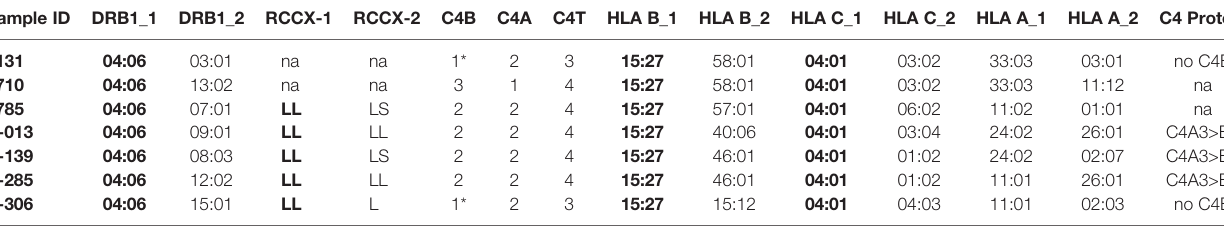
TABLE 4 | HLA genotypes and RCCX modules in East-Asian subjects with W660x mutation in C4B